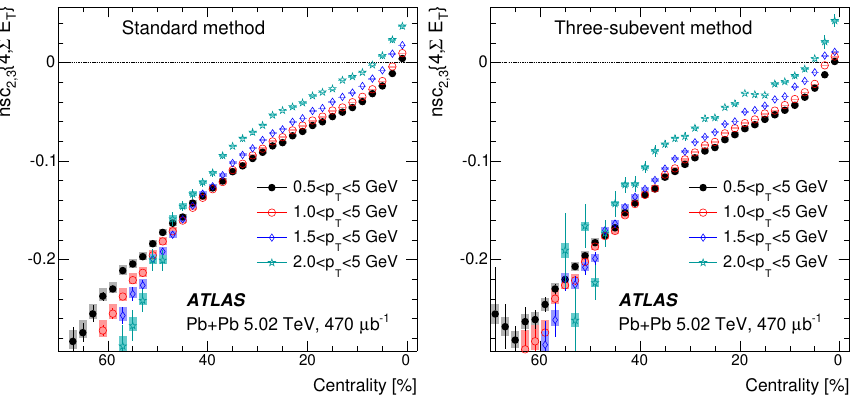
Figure 10 . The centrality dependence of nsc 2 ; 3 f 4 g calculated for charged particles in four p T ranges with the standard method (left panel) and three-subevent method (right panel). The error bars and shaded boxes represent the statistical and systematic uncertainties, respectively. Zero is indicated by a dotted